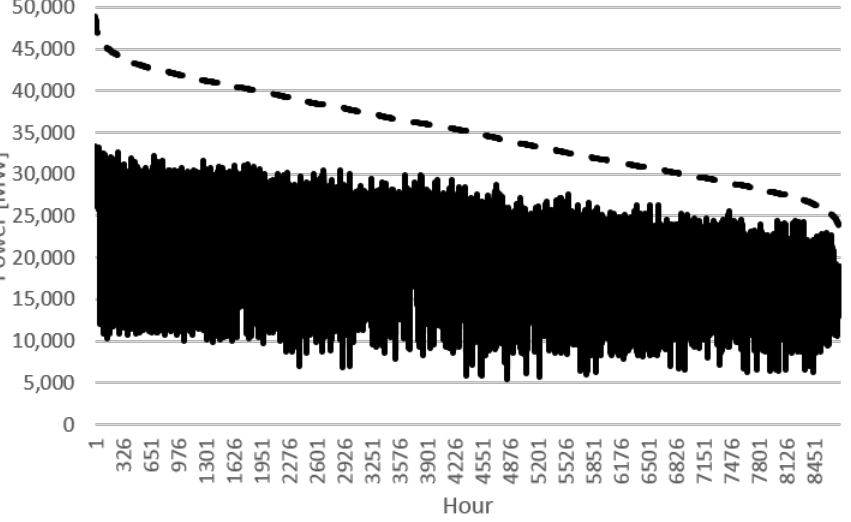
Figure 3. Demand monotone curve (dashed black line) and its respective hourly net load in 2018.